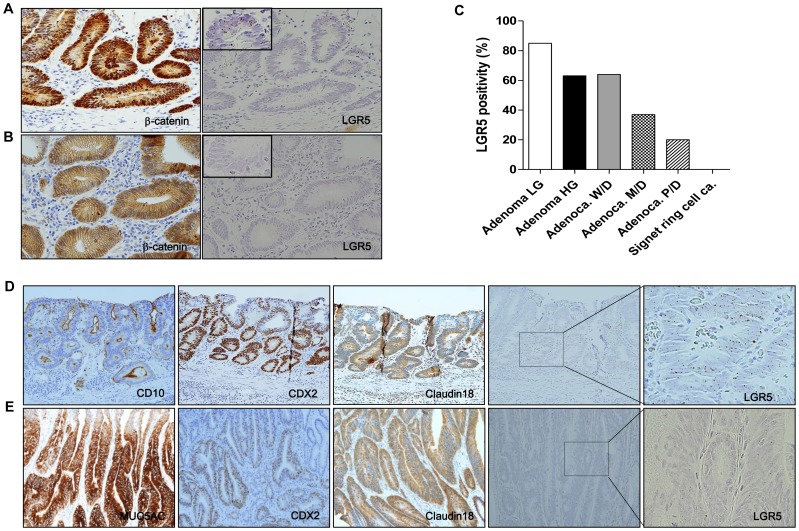
Relationships between LGR5 positivity and nuclear β-catenin, histological differentiation, and mucinous type in gastric adenomas.Gastric adenomas with strong cytoplasmic and nuclear β-catenin expression (n = 44) were highly likely to be positive for LGR5 (A), whereas adenomas with normal β-catenin expression levels (n = 31) had relatively low LGR5 positivity (B). (C) As the tumors progressed and dedifferentiated, LGR5 positivity declined (n = 143). Intestinal-type adenomas (n = 30) (A) generally had higher levels of LGR5 expression than gastric-type adenomas (n = 13) (E). CD10 and MUC2 expression refers to the intestinal tumor gland phenotype, and MUC5AC and MUC6 mucin expression represents the gastric gland phenotype. LG, low grade; HG, high grade; Adenoca, adenocarcinoma; W/D, well differentiated; M/D, moderately differentiated; P/D, poorly differentiated. Magnifications: A, B, D, E, ×200.